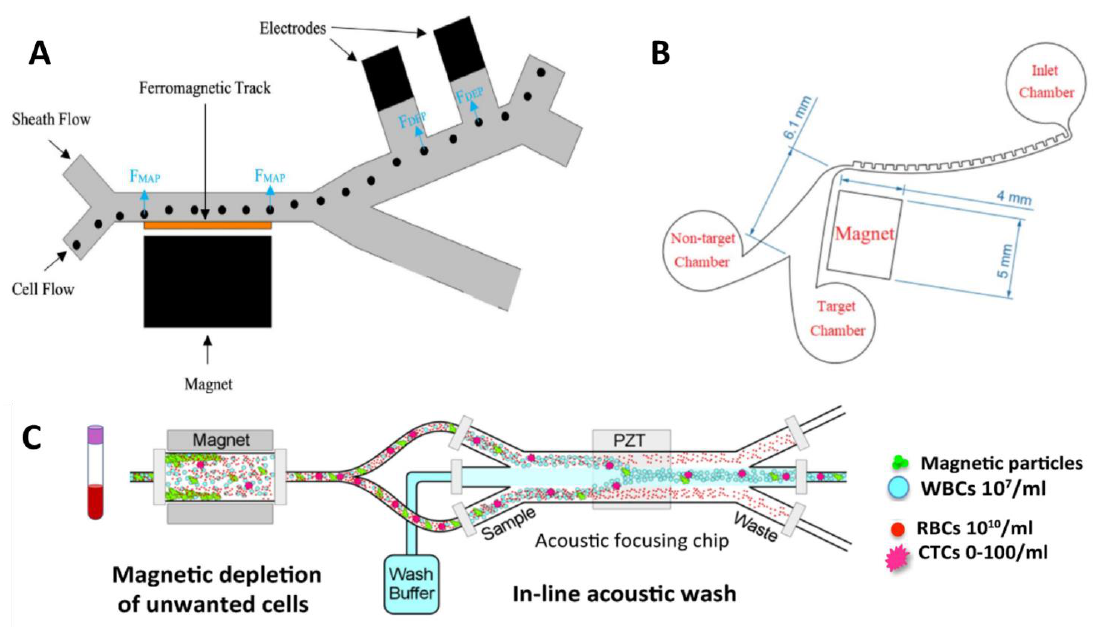
Figure 16. Illustrations of cell separators combining MAP with other forces. ( A ) A combined dielectrophoresis and magnetophoresis separator based on cell intrinsic properties. Reprinted from [152]. ( B ) Centrifugal microfluidic platform using hydrodynamic and magnetophoretic techniques, reprinted from [202]. ( C ) Approach combining immunomagnetic depletion and acoustic cell sorting. Reprinted from [200].